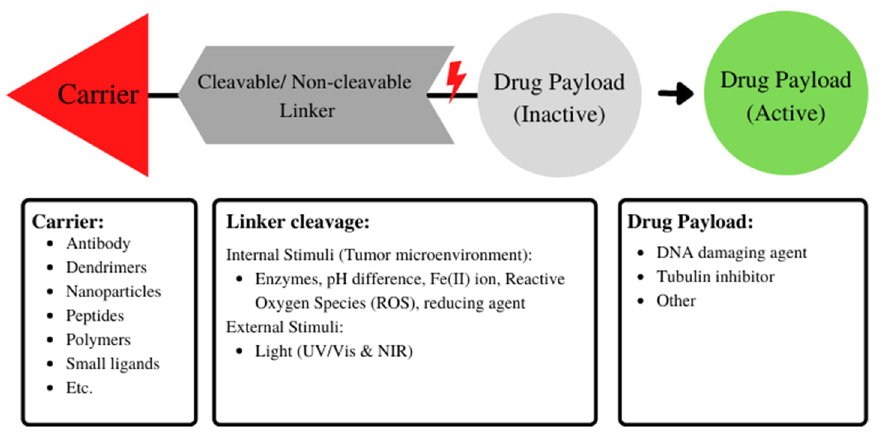
Figure 1. Schematic representation of various drug conjugates.